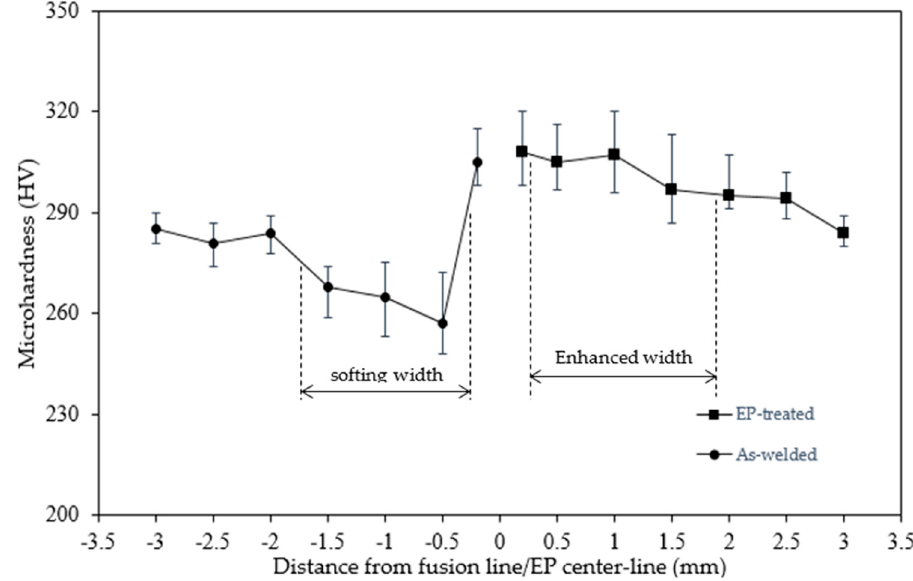
Figure 9. Microhardness of the EP-treated and the as-welded microstructures. The increment in strength ∆𝜎 (cid:3052) is the sum increment of grain size strengthening ( ∆𝜎 (cid:3008)